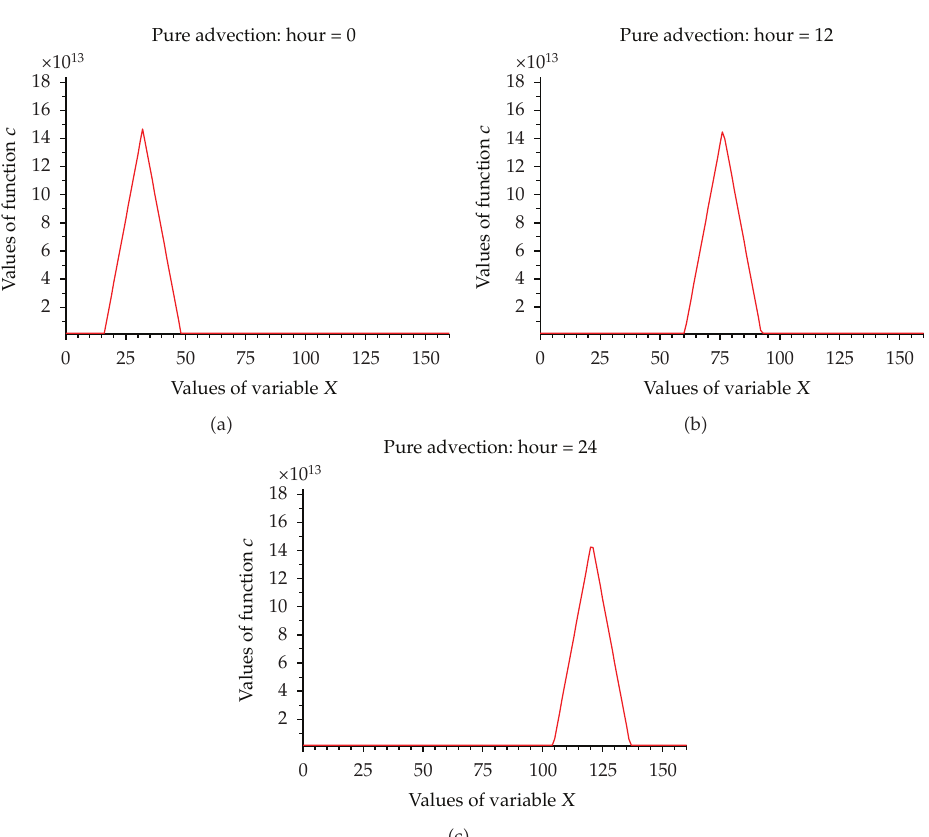
Figure 3: The solution of the one-dimensional advection equation defined in Section 5.4 is drawn (cid:6) a (cid:7) at the beginning of the interval (cid:6) the upper plot (cid:7) , (cid:6) b (cid:7) at the end of the twelfth hour (cid:6) the plot in the middle (cid:7) , and (cid:6) c (cid:7) at the end of the time interval (cid:6) the lower plot (cid:7)